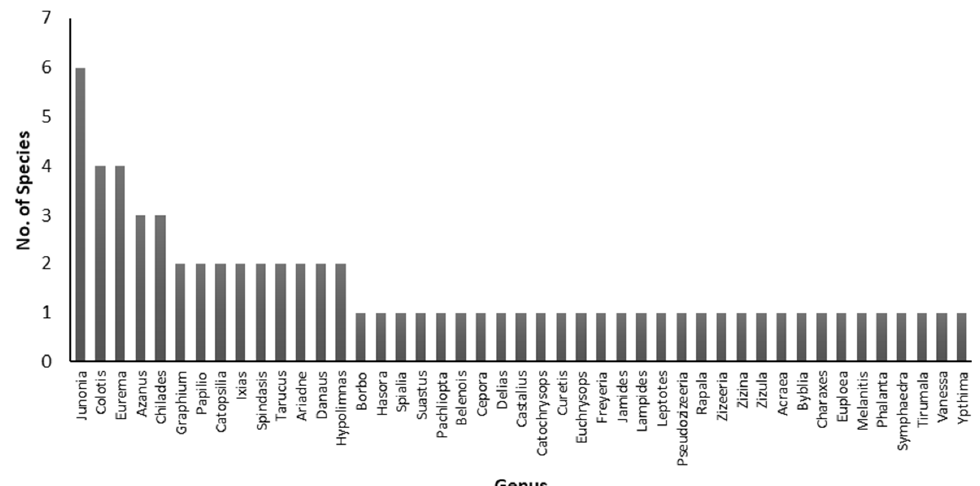
Figure 3. Distribution of butterfly species belonging to different genera in the study